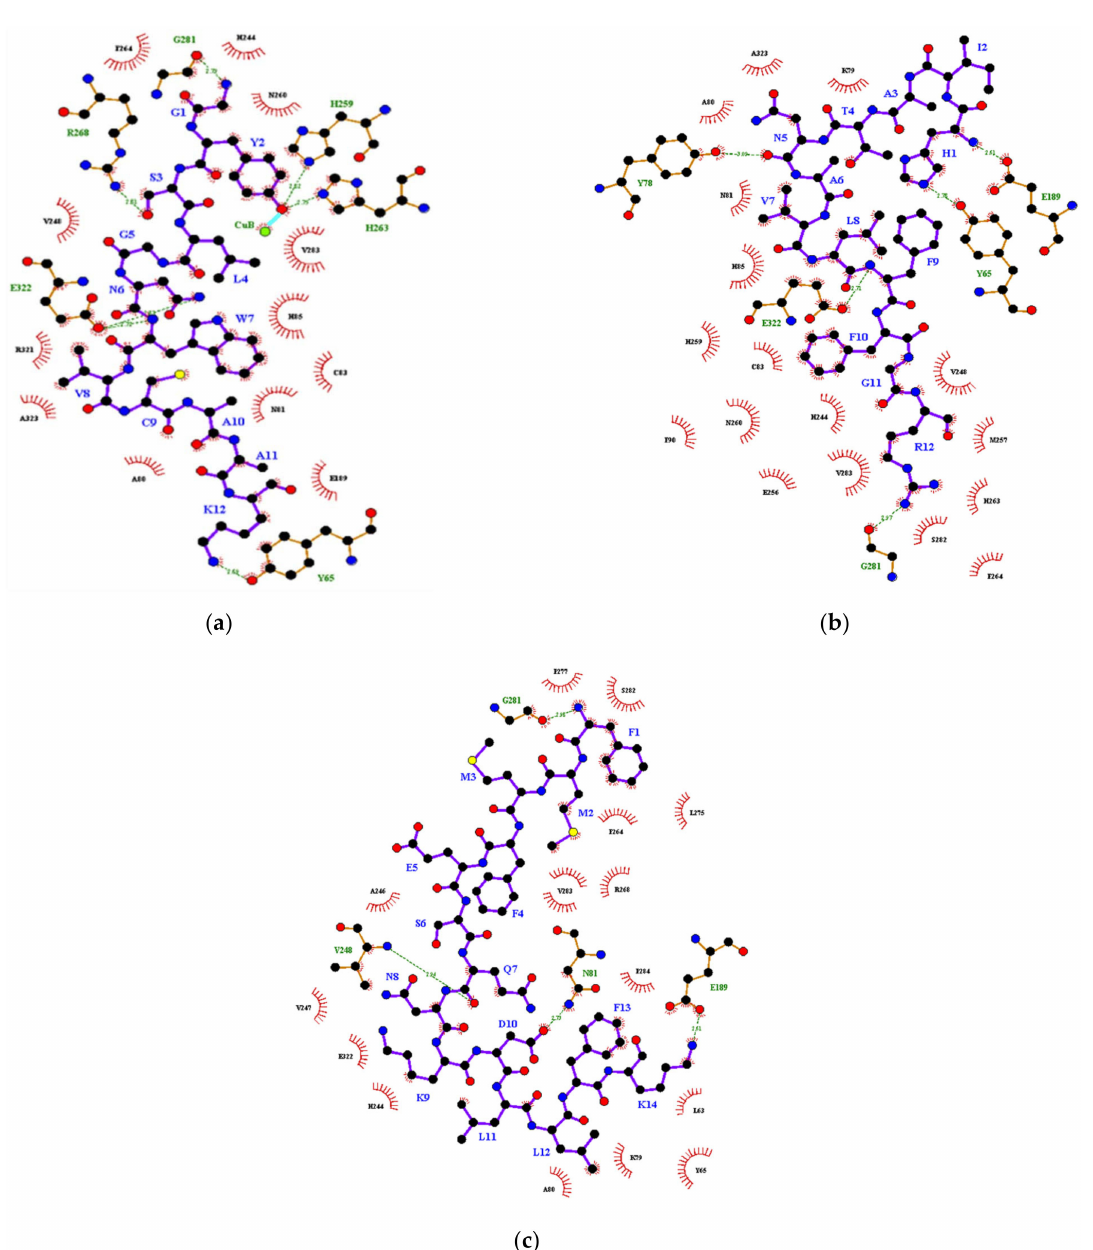
Figure 4. Binding interactions between ( a ) DIP1, ( b ) DIP2, ( c ) DIP3 and tyrosinase during the diphenolase reaction. Red ball, oxygen atom; green ball, copper atom; blue ball, nitrogen atom; black ball, carbon atom; yellow ball, cysteine atom; purple line, peptide; brown line, tyrosinase; cyan line, covalent bond; red dotted line, salt bridge; green dotted line with number, hydrogen bonding and the distance (in Armstrong, Å) between proton donor and acceptor; brick red eyelashes, hydrophobic